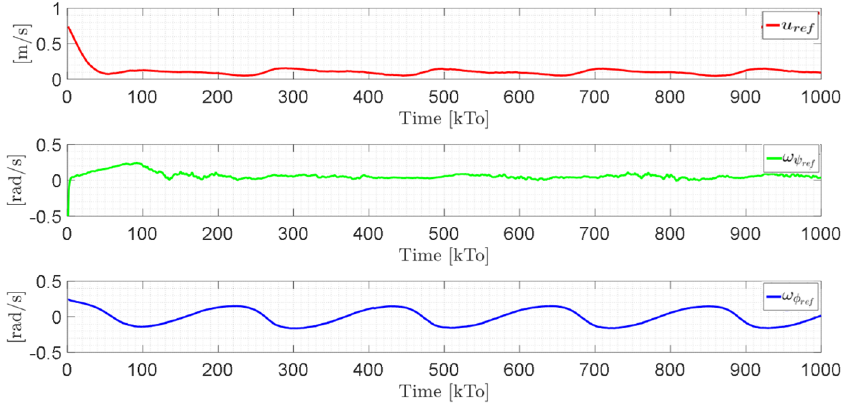
(cid:16) (cid:17) ( kT ) = u ref , ω ψ , ω φ 0 ref ref